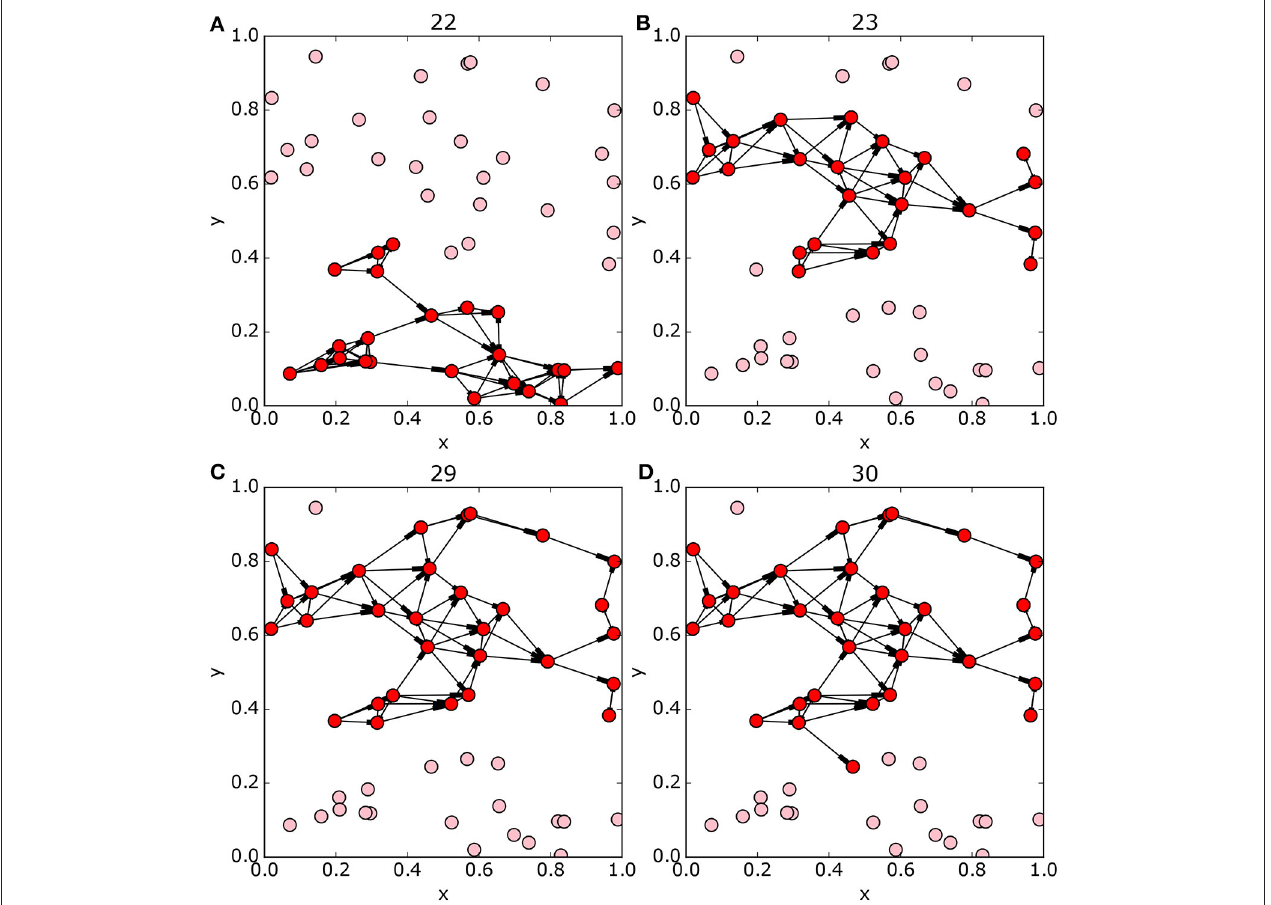
FIGURE 9 | Pareto-optimal subnetworks, bright red nodes are included in the network, light red are excluded. Panels (A,B) show the networks either side of the subnetwork structural discontinuity at solution 22 in Figure 8B . There is a step change in optimal network structure with the addition of just a single site to the optimal solution, from exclusively “southern” sites ( y < 0.4) to exclusively on “northern” sites ( y > 0.4). Panels (C,D) show the optimal subnetworks around the change in gradient in the Pareto front at 29 nodes ( Figure 8A ). Subnetworks of more than 30 nodes must include sites from both the “northern” and “southern” groups and the average shortest path improves more